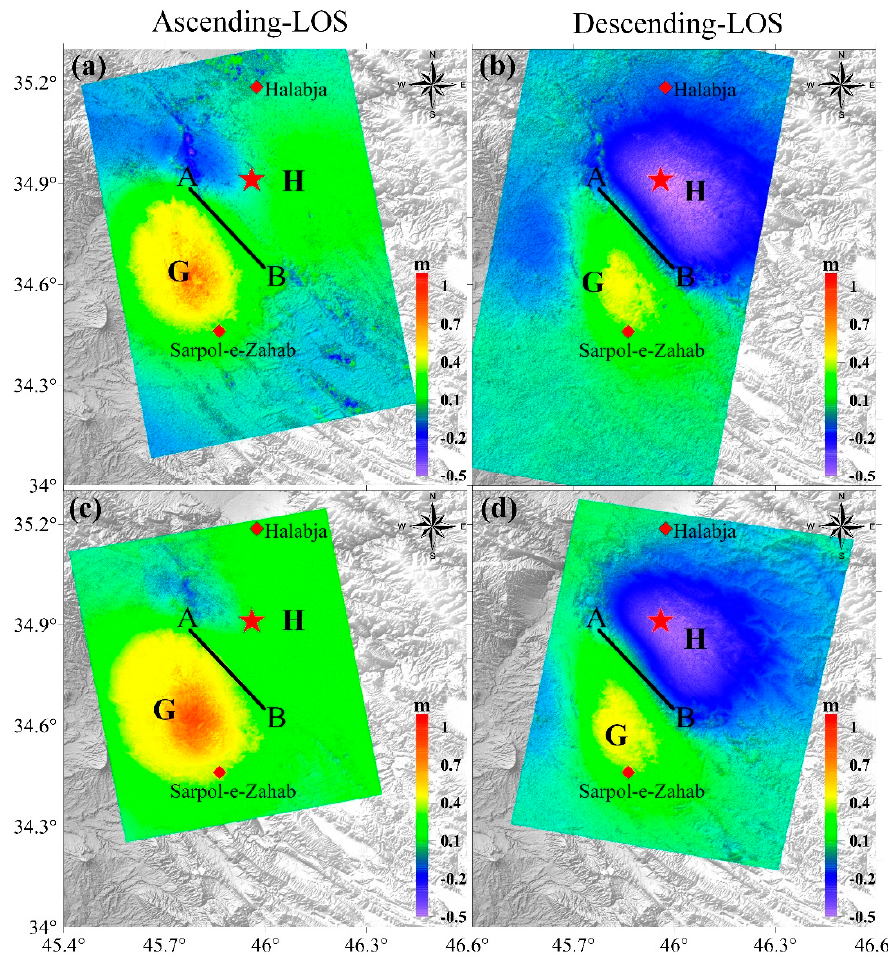
Figure 2. The coseismic deformation maps in the LOS directions. ( a ) and ( b ) obtained from ALOS-2 DInSAR processing. ( c ) and ( d ) obtained from Sentinel-1a DInSAR processing. The red star represents the epicenter of the mainshock; The red solid squares represent the city Halabja and Sarpol-e-Zahab. The black line AB is the deformation bound.